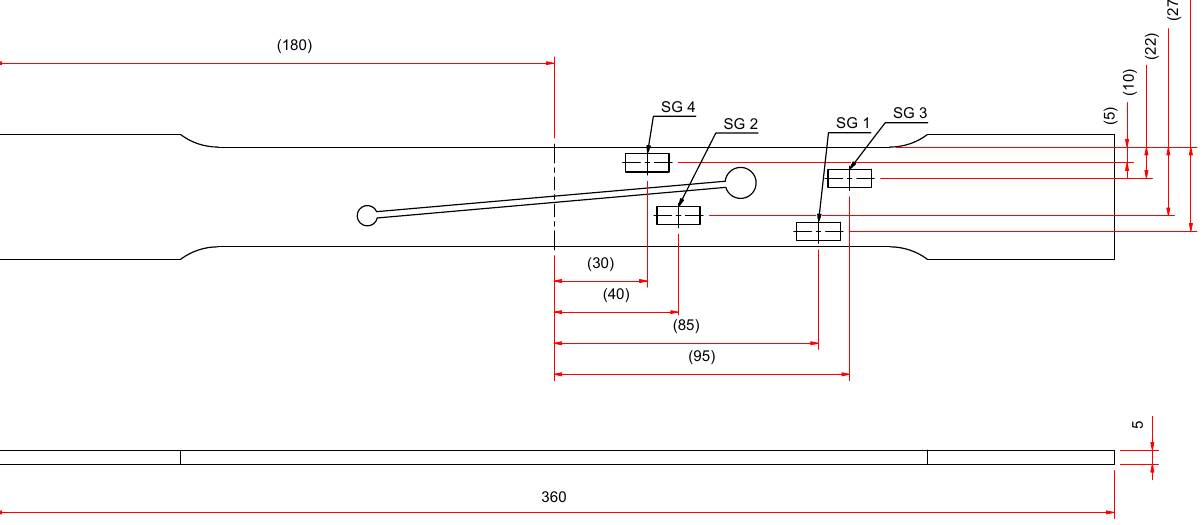
Figure 4. Schematic of the simple test specimen and the locations and naming conventions of strain gauges. Dimensions are in millimetres.